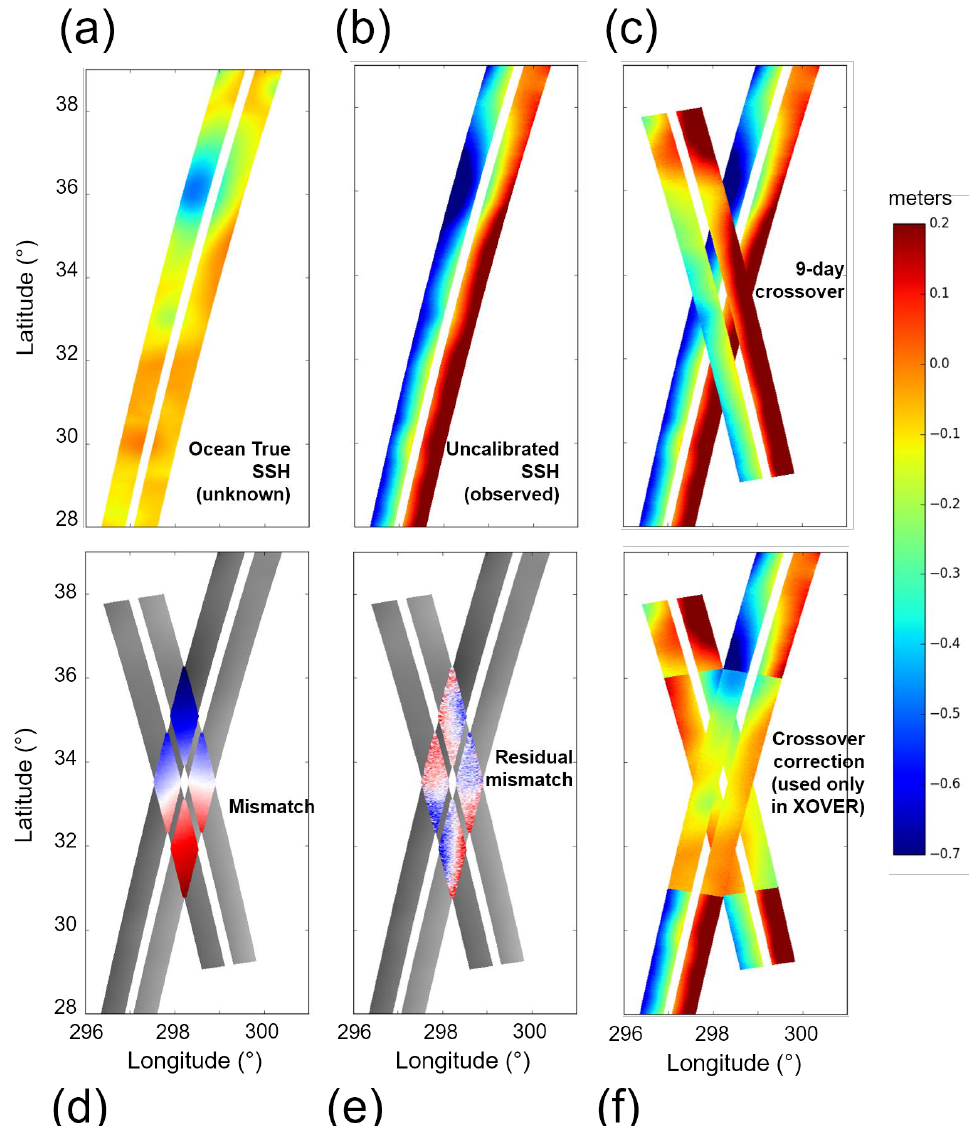
Figure 10. Step-by-step inversion of the crossover retrieval method. Panel ( a ) shows a segment of KaRIn image without any error (simulated ground truth from the GLORYS model). Panel ( b ) is the same segment when we add the random and systematic errors. Panel ( c ) is when we add an overlapping KaRIn images from 9-days before. Panel ( d ) is the image-to-image difference for the overlapping diamond between the two images from panel ( c ). Panel ( e ) is the residual mismatch after we adjust the linear and quadratic models for each image. Panel ( f ) is when the model adjusted is applied in each swath as a local calibration.